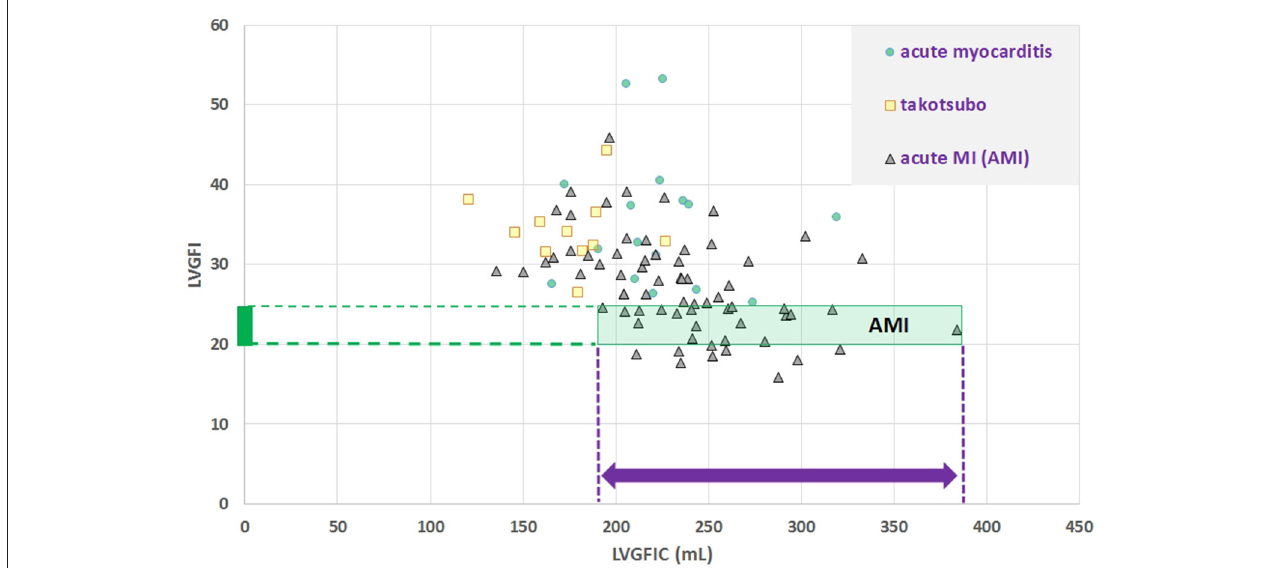
FIGURE 2 | Scatter plot for dimensionless LVGFI vs. its companion metric LVGFIC (mL). The green rectangular area illustrates that e.g., for the narrow range 20 < LVGFI < 25 % this metric is not unique, as for the interval the individual data points are rather characterized by the prevailing LVGFIC (mL), with values between 193 and 384mL. Correlations are not significant for the diagnostic subgroups, with the exception of acute myocardial infarction (MI), where R